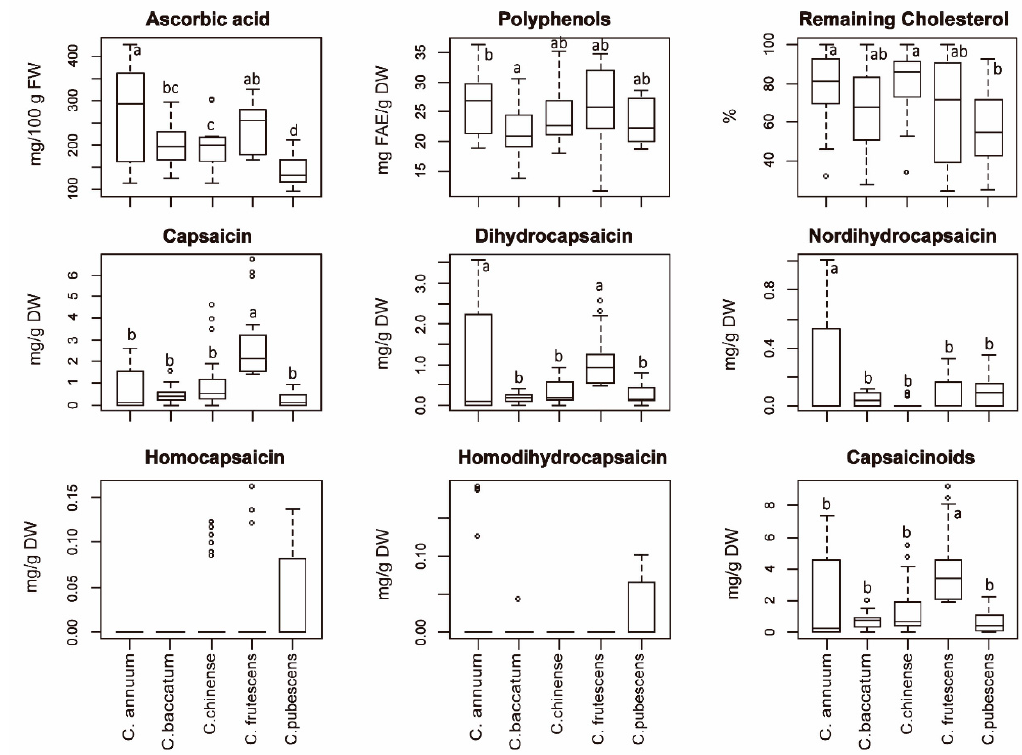
Figure 1. Box plot of biochemical parameters. Twenty-fifth percentile, median, 75th percentile, and range minimum-maximum. Outliers (white circle) were identified as 1.5 times the interquartile range. Different letters indicate significant differences at p < 0.05.